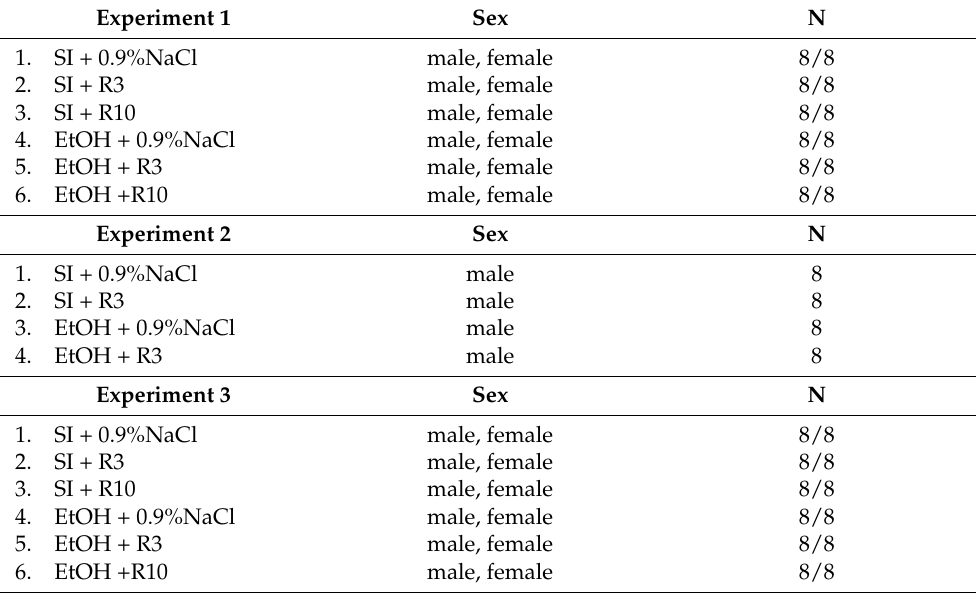
Table 1. Experimental groups. SI–shame intubation (i.g.); EtOH–ethanol intubation (i.g.);